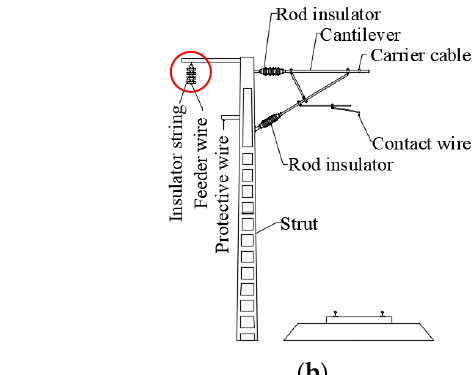
Table 1. Main technical parameters of U70BL insulator.